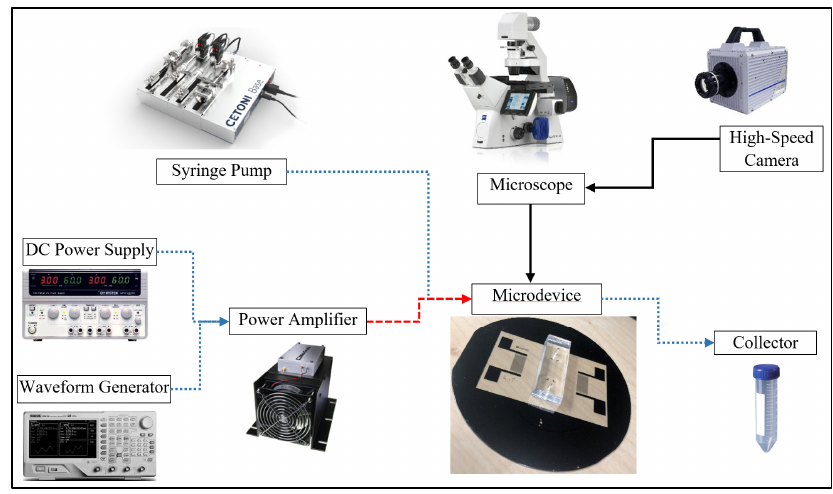
Figure 11. Experimental setup used to perform SSAW-related experiments.